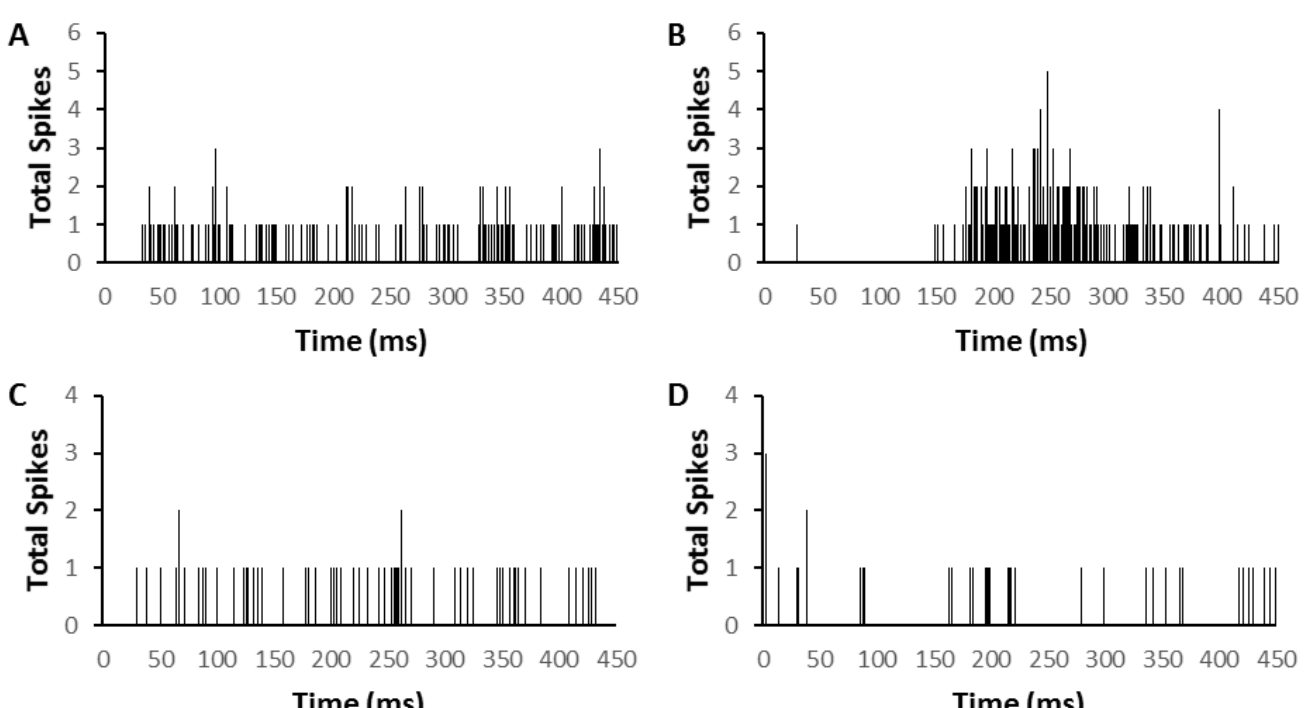
Figure 1. Time histograms (75 sweeps) showing two examples of medial geniculate nucleus (MGN) neuron firing in silence before (left column, ( A , C )) and after (right column ( B , D )) brief repetitive electrical stimulation of prefrontal cortex (PFC) (pulse duration 0.5 ms, train duration 50 ms, rate 200 Hz). ( A , B ) Onset response neuron (CF = 2.8 kHz; threshold = 30 dB) showing increase in firing after PFC electrical stimulation. ( C , D ) Onset response neuron (CF = 8.1 kHz; threshold = 78 dB) showing decrease increase in firing after PFC electrical stimulation. The time point of 0 denotes the end of electrical stimulus in ( B , D ).